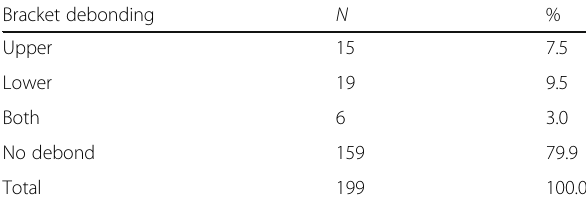
Table 1 Descriptive statistics of bracket debonding incidence